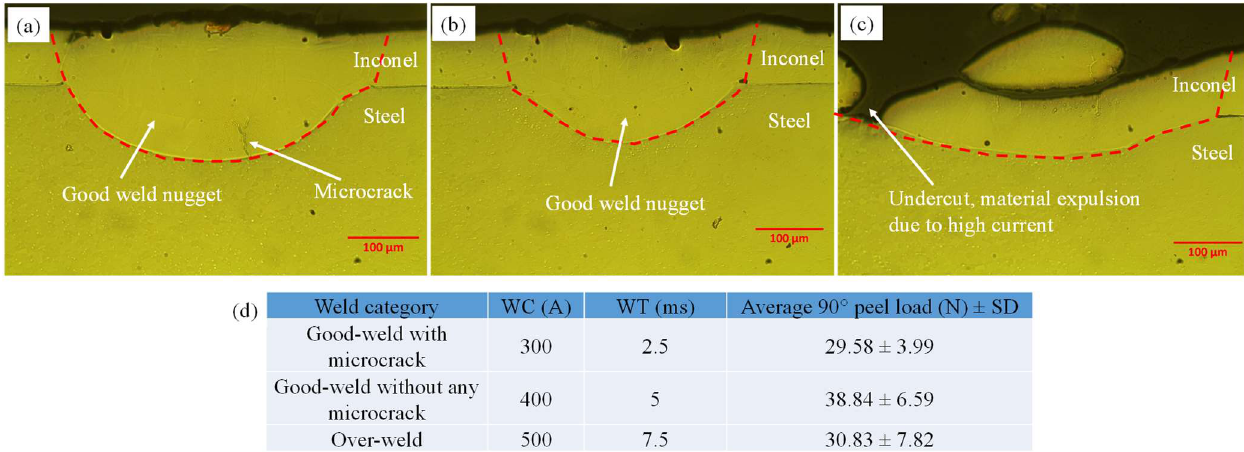
Figure 5. Optical micrographs of micro-RSW welded joints at ( a ) good weld with microcrack, ( b ) good weld without microcrack and ( c ) over-weld conditions with ( d ) the parameters used for the welding.